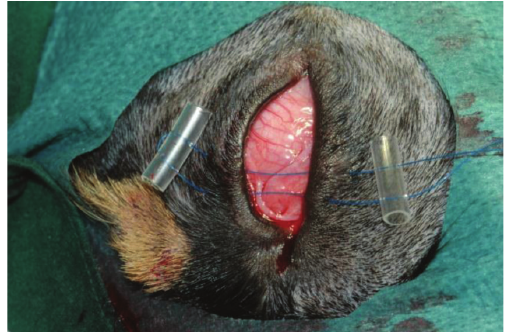
Figure 8: Six-and-a-half-month-old Bernese mountain dog with intraocular and extraocular prosthesis two months after surgery.